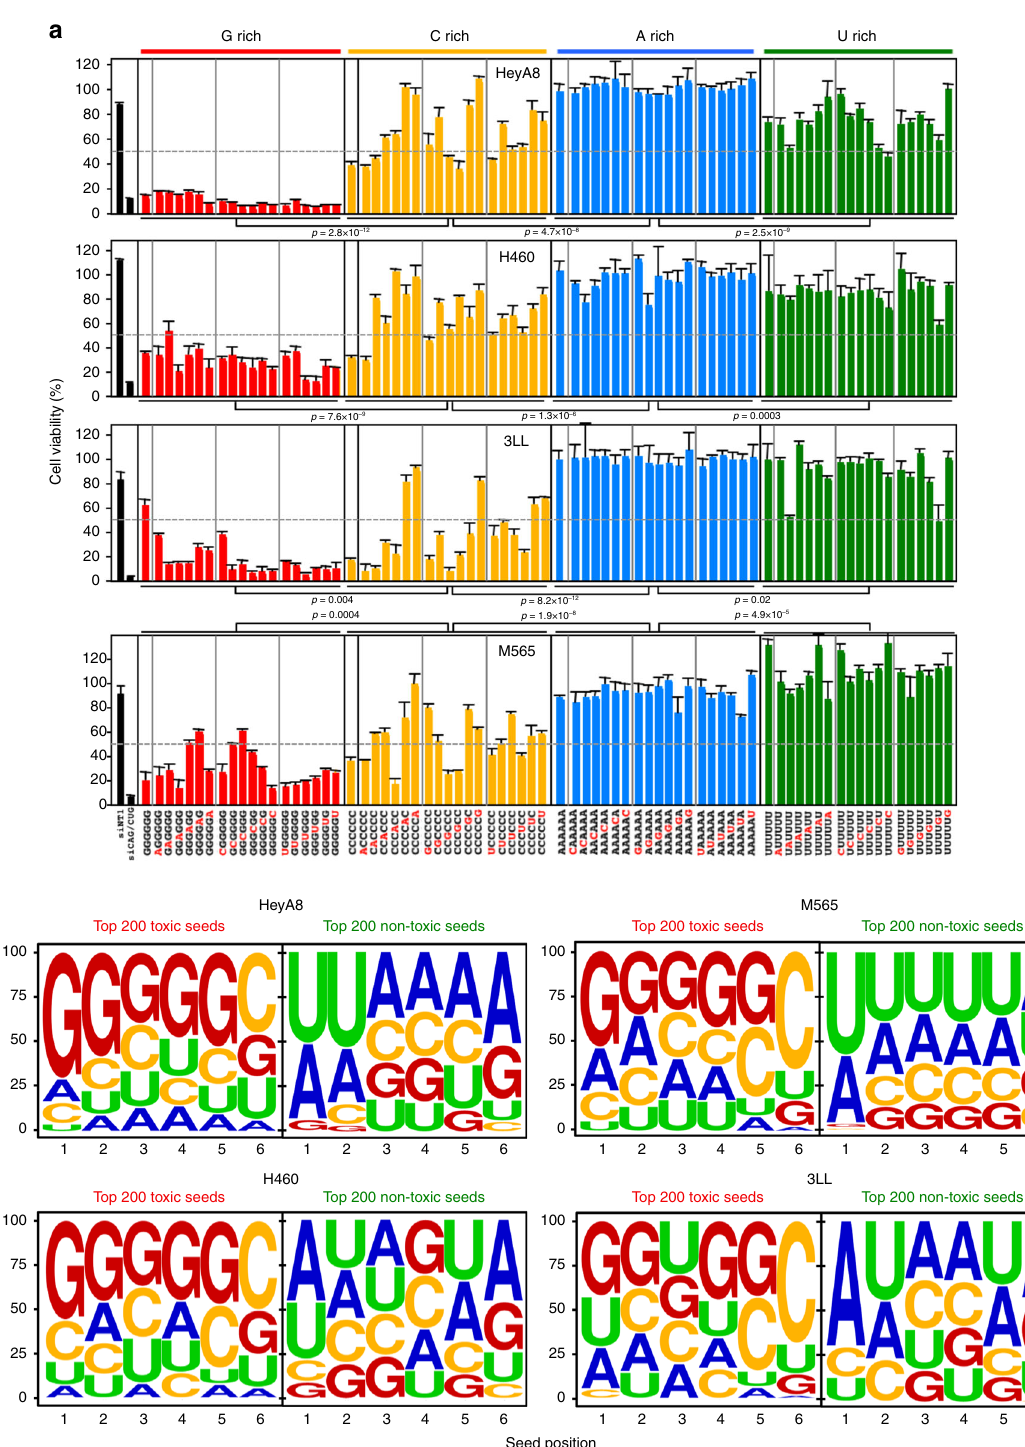
Fig. 2 The most toxic seeds are G rich. a Cell viability of the 19 seed duplexes with the highest content (>80%) in the 6mer seed region for each nucleotide in two human and two mouse cell lines. Samples were analyzed in triplicate and mean ± SD for each sample is shown. p -Values between groups of duplexes were calculated using Student ’ s t -test. siRNAs are considered to be toxic when viability is inhibited >50% (gray stippled line). b Nucleotide composition at each of the six seed positions in the top 200 most toxic (left) or the top 200 least toxic (right) seed duplexes in the four cell